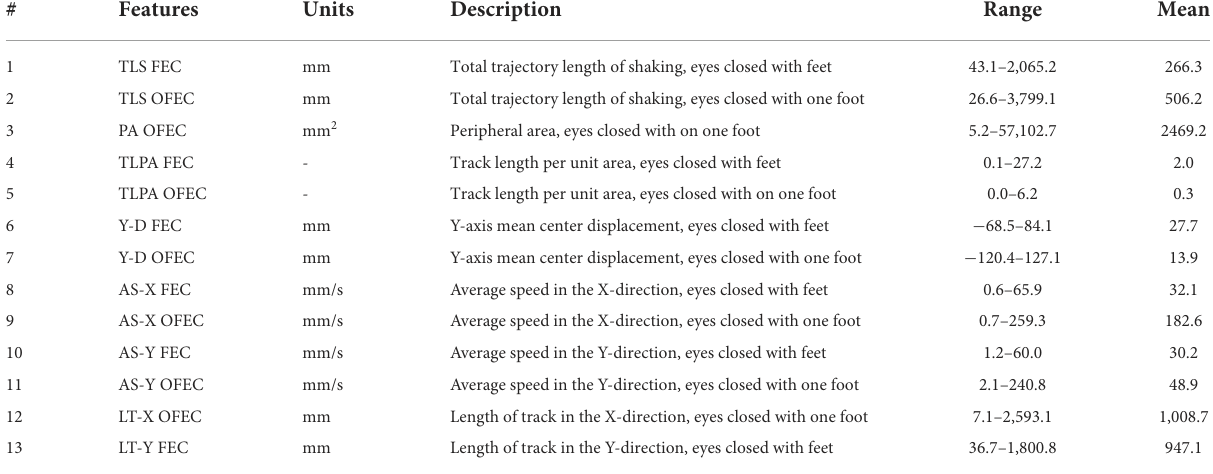
TABLE 1 The selected 13 features.